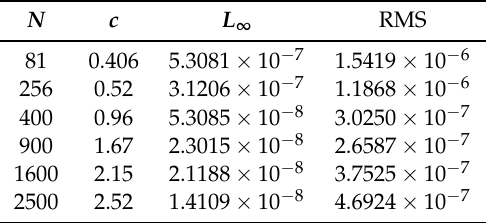
Table 2. Error norms for Problems 2.